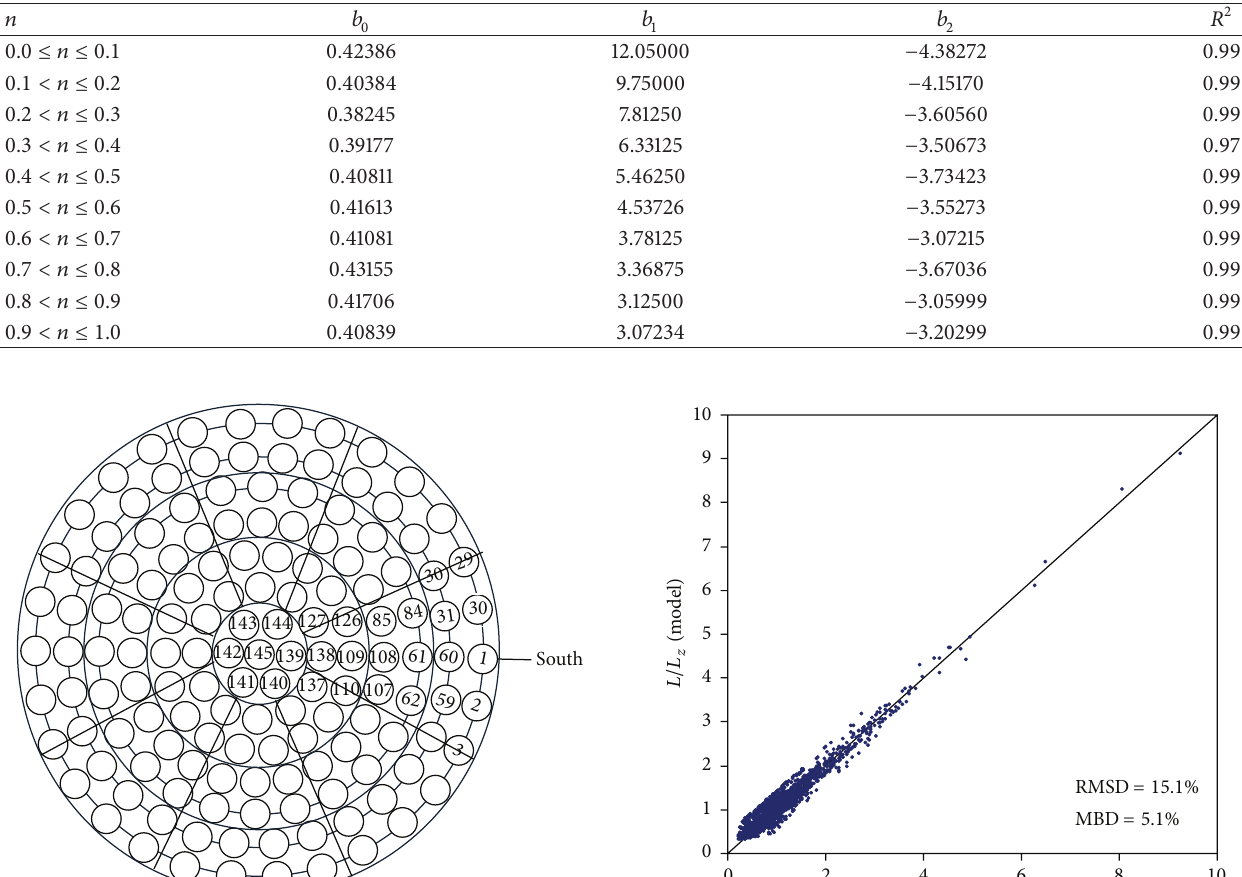
Table 4: Values of the coefficients of (17). 𝑅 2 is coefficient of determination.